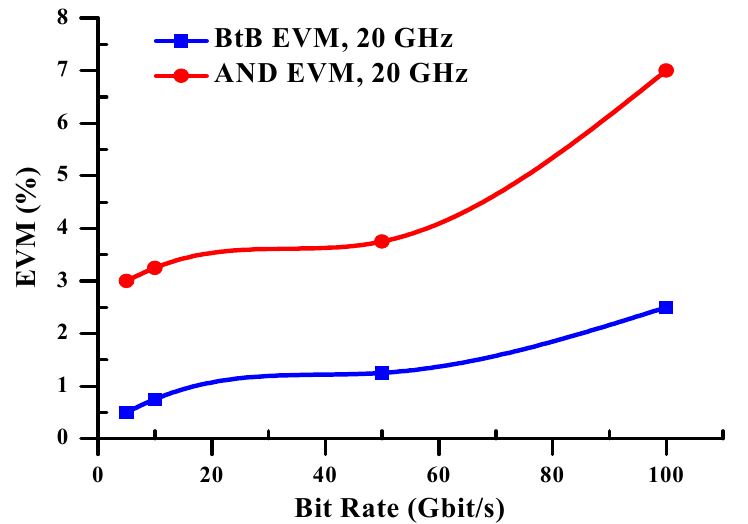
Figure 11. Experimental back to back (BtB) values of the 16-QAM EVMs and the 16-QAM “AND” signal at 20 GHz for a miscellany of bit rates.